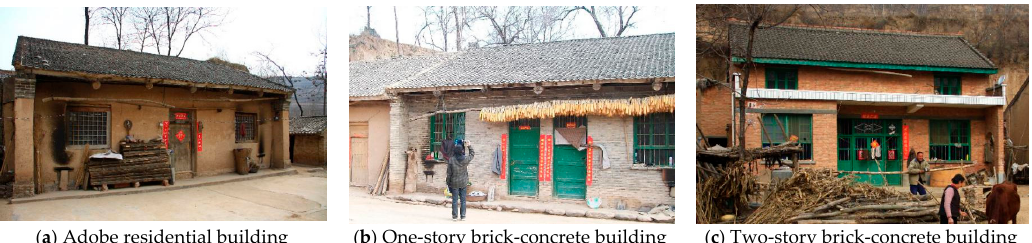
Figure 4. Location of Nan Zhai town. Table 2. Overview of three different kinds of residential buildings.